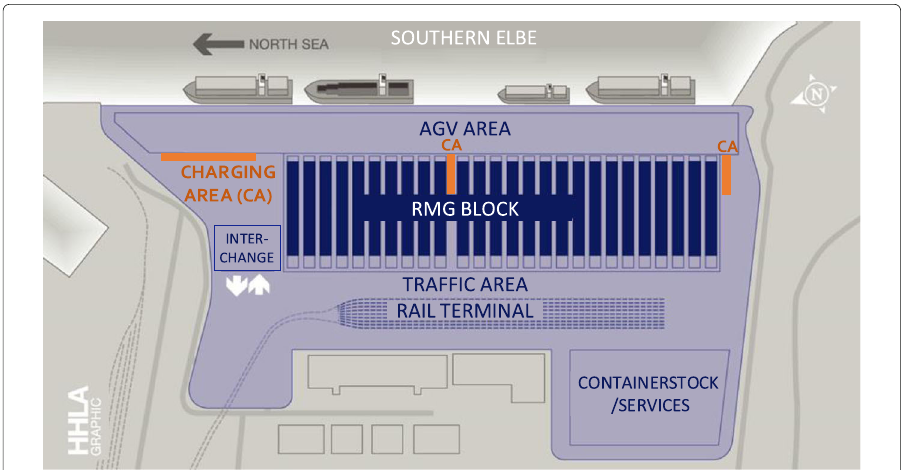
Fig. 1 Schematic layout of the Container Terminal Altenwerder and location of built / planned Automated Charging Stations ( ACS ). Image provided by and copyright with